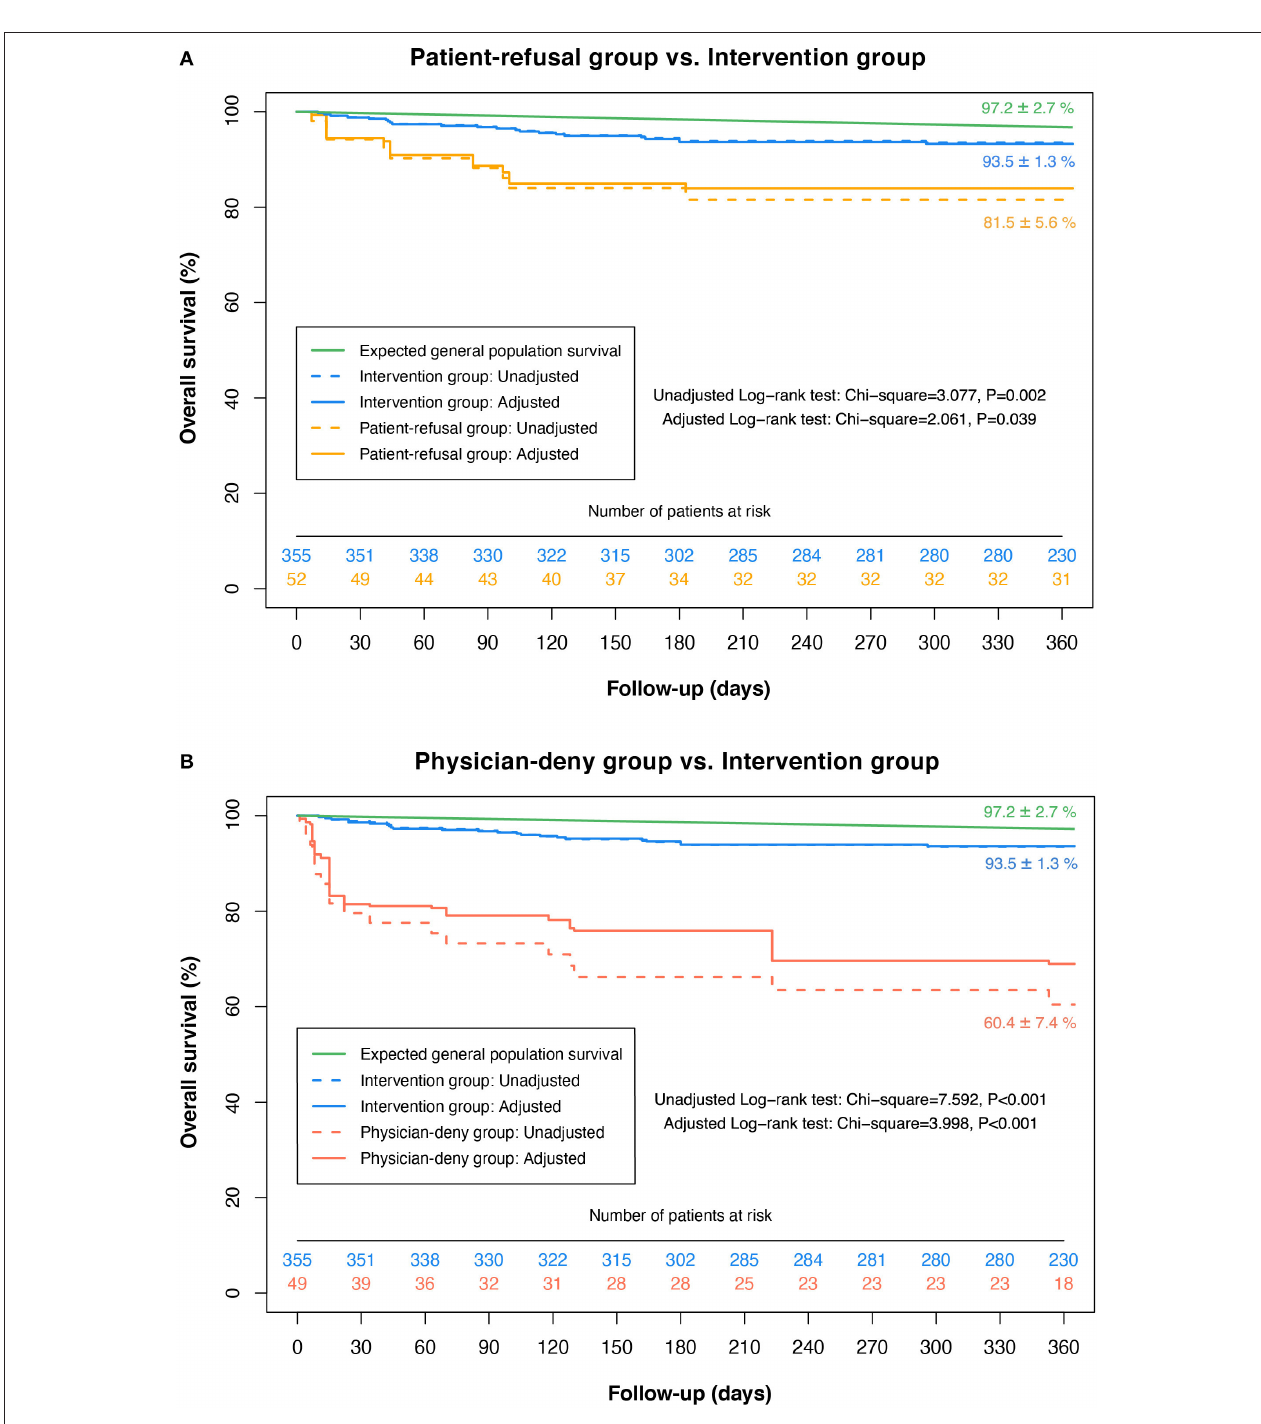
FIGURE 4 | Kaplan-Meier survival curves for patients with different therapeutic decisions. The plot showing the survival distributions of patients who accepted the intervention proposal (Blue); refused the intervention proposal (Yellow); were denied intervention by physicians (Red), as well as the expected survival of the age- and sex-specific general population (Green). The dash lines represent the crude survival rates and the solid lines indicate the adjusted survival rates using